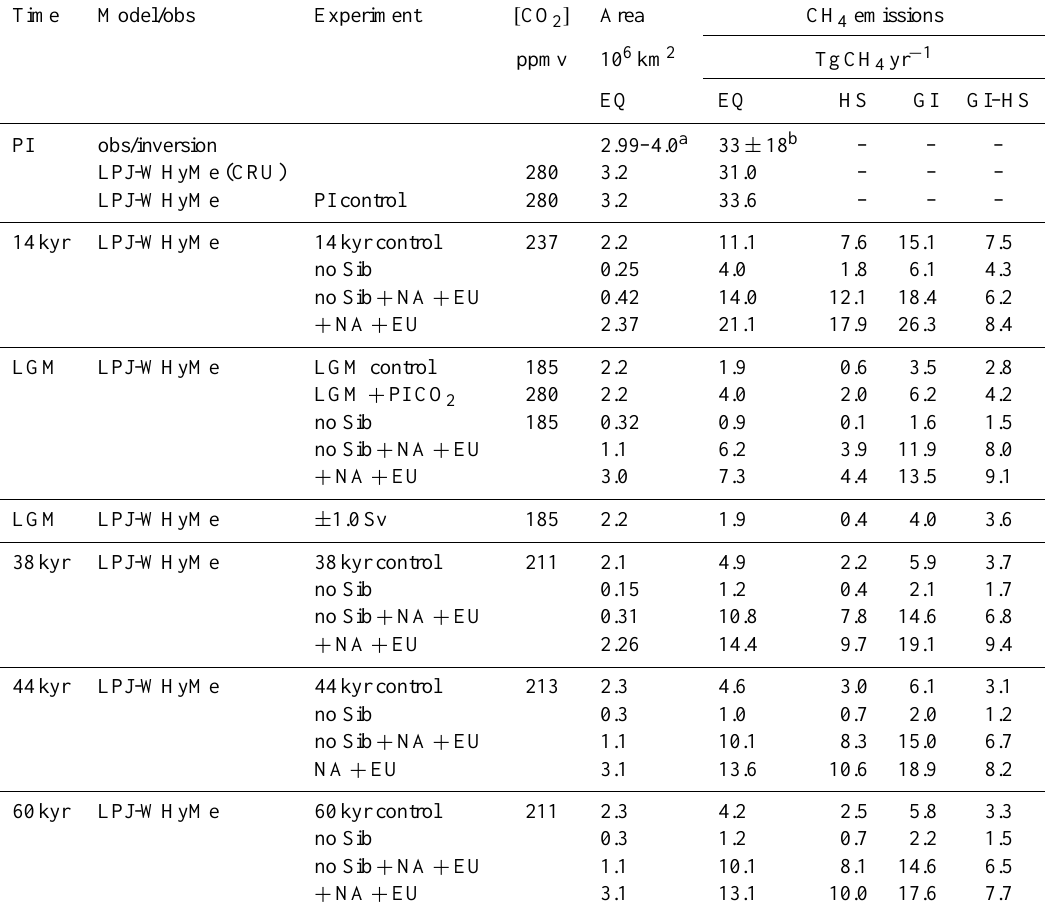
Table 3. CH 4 emissions in LPJ-WHyMe and as inferred from observations. no Sib indicates that the Siberia peat complex is omitted, and NA+EU denotes extra peatland areas introduced in North America and Europe as described in the main text. All forcing climates are as simulated directly by FAMOUS, except LPJ-WHyMe (CRU) which is forced with regridded 1961–1990 mean climatological observations (New et al., 1999). ± 1.0Sv denotes the transient LGM simulation with double the magnitude of freshwater